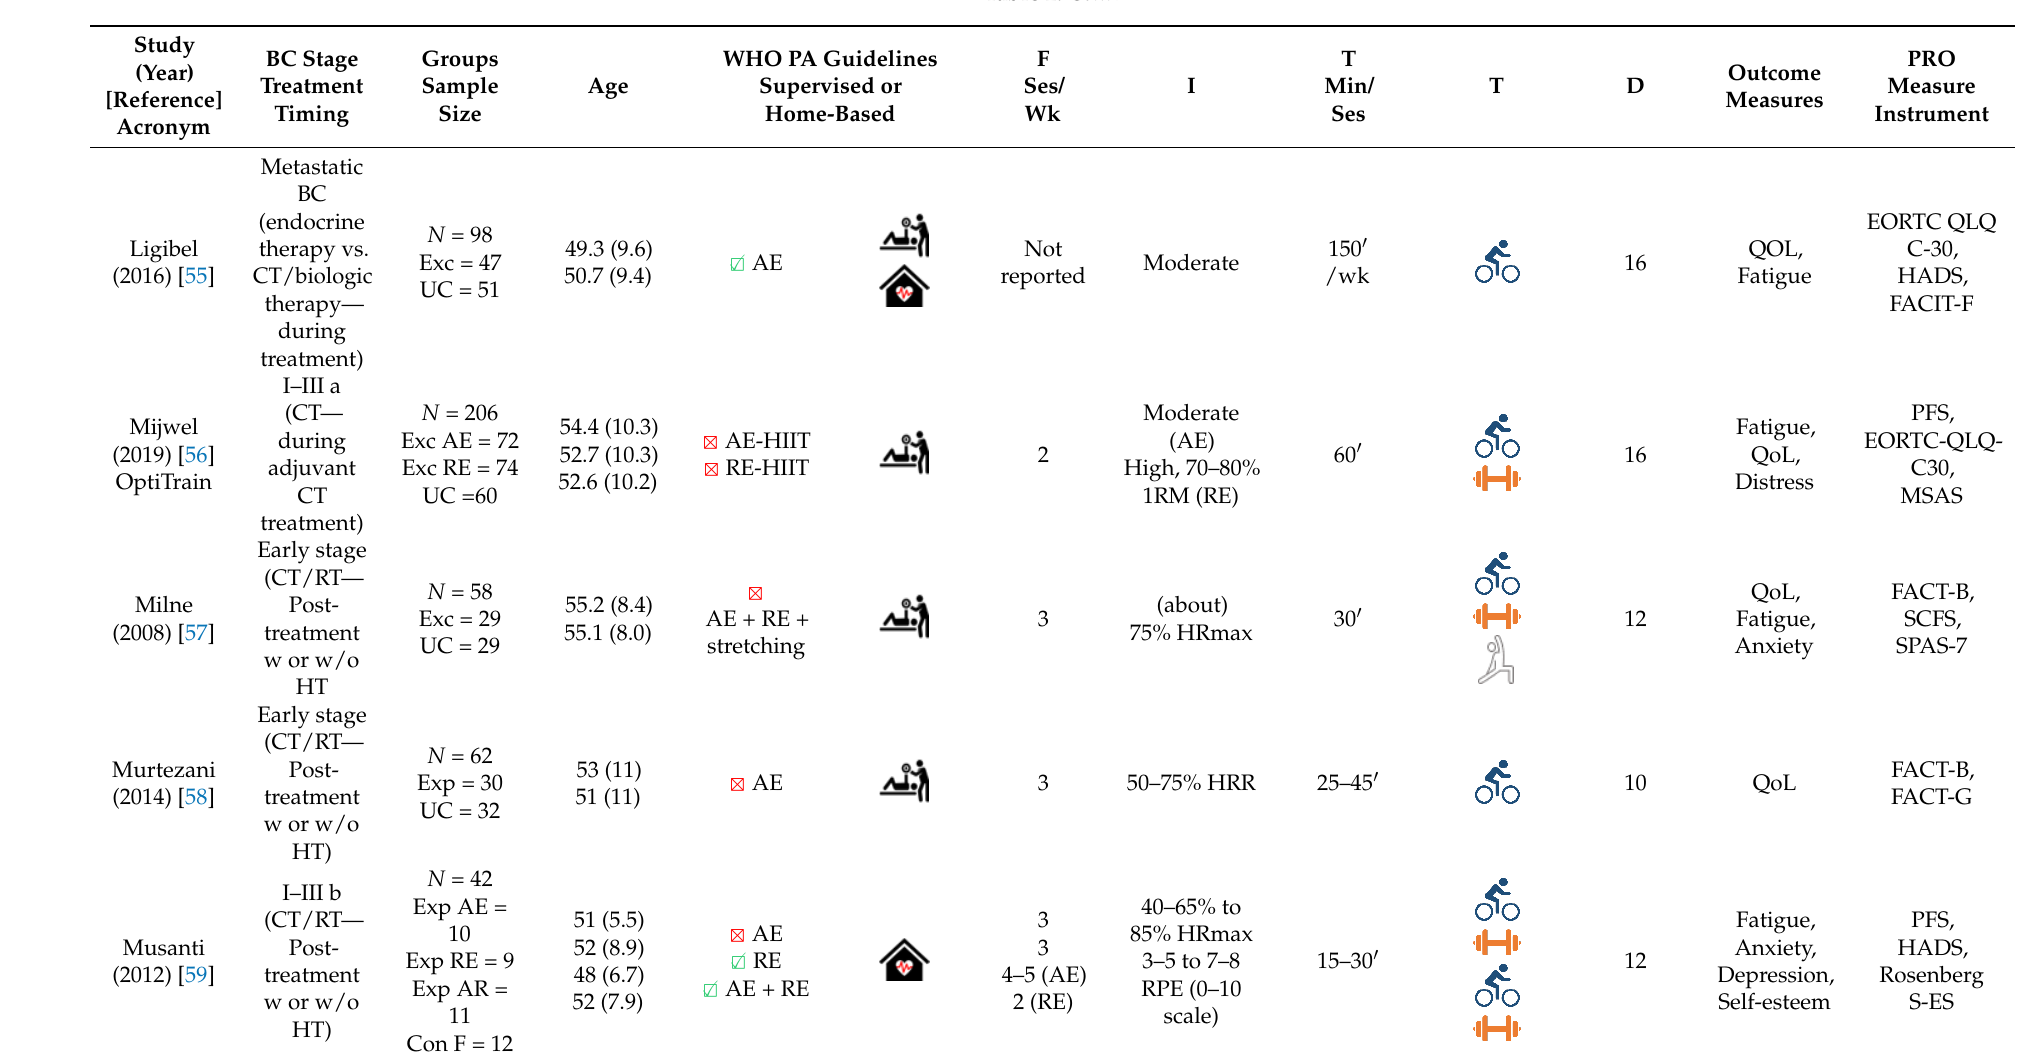
Frequency, Intensity, Time and Type (FITT); Duration (D); Patient Reported Outcome (PRO); Exercise intervention group (Exc); Usual care or control group (UC); Aerobic Exercise training (AE); Resistance Exercise training (RE); WHO guidelines of minimum physical activity/exercise recommended ( : accomplished; not accomplished); Chemotherapy (CT); Radiotherapy (RT); Hormonal Therapy (HT); Quality of Life (QoL); ratings of perceived exertion (RPE); moderate to vigorous physical activity (MVPA); Heart Rate Reserve (HRR); Ductal Carcinoma in Situ (DCIS); PRO measures: Beck Depression Inventory (BDI); The Brief Fatigue Inventory (BFI); European Organization for Research and Treatment of Cancer Quality of Life Questionnaire (EORTC QLQ-C30); Finnish modified version of Beck’s 13-item depression scale (RBDI); Functional Assessment of Cancer Therapy, FACT-Anemia (FACT- A); Functional Assessment of Cancer Therapy-Anemia (FACT-An); Breast (FACT-B); Fatigue (FACT-F); General (FACT-G); Functional Assessment of Chronic Illness Therapy (FACIT); questionnaire for fatigue (FACIT-F); Medical Outcomes Study Short Form (MOS SF-36); Piper Fatigue Scale (PFS); Schwartz Cancer Fatigue Scale (SCF); Women’s Health Questionnaire (WHQ); Patient Reported Outcomes Measurement Information System (PROMIS); Body Image Scale (BIS); Happiness Measure (HM); Social Physique Anxiety Scale-7 items (SPAS-7); Memorial Symptom Assessment Scale (MSAS); Fatigue Assessment Questionnaire (FAQ); Hospital Anxiety and Depression Scale (HADS); HADS-Anxiety (HADS-A); HADS-Depres- sion (HADS-D); Pittsburgh Sleep Quality Index (PSQI); Rosenberg Self-Esteem scale (S-ES); Center for Epidemiological Studies Depression Scale (CES-D); Spielberger State Anxiety Inventory (SAI); Physical Function scale (SF-36); World Health Organization Quality of Life-BREF (WHOQOL-BREF); State-Trait Anxiety Inventory, (STAI); STAI-State Anxiety (STAI- YI), Cohen’s 10-item Perceived Stress Scale (10-PSS); Trial Outcome Index-Anemia (TOI-An) subscale and fatigue subscale; Health Related Quality of Life (HRQoL); Profile of Mood States (POMS); Linear analog scale for fatigue (LASF); Cancer Rehabilitation Evaluation System-Short Form (CARES-SF); Body Image and Relationships Scale (BIRS). * Age presented with mean and SD or range where reported.